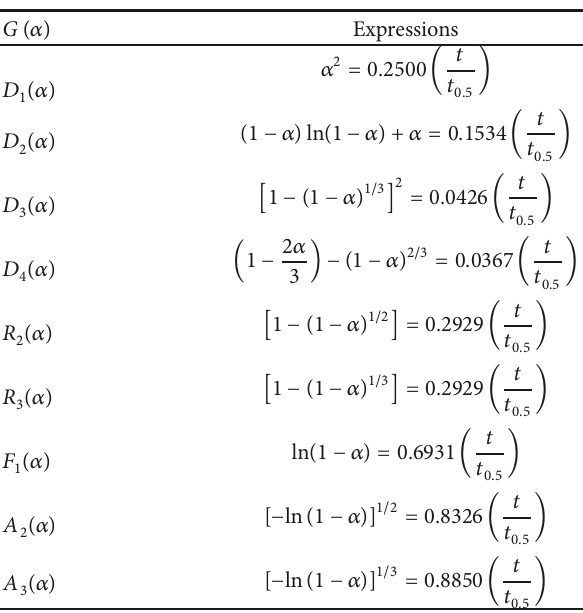
Table 2: Nine commonly used mechanism functions.